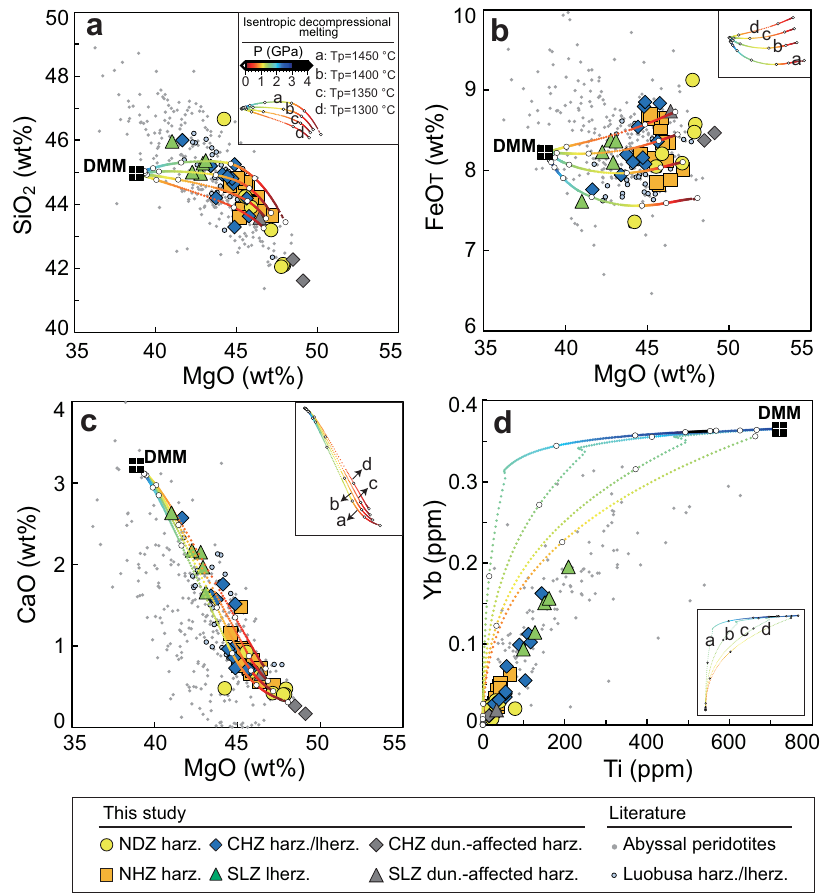
Fig. 3 | Whole-rock compositional variations of the Kangjinla ophiolitic peri- dotites and decompressional melting modeling. Variations of whole-rock MgO (wt%)versusSiO 2 (wt%, a ),FeO T (wt%, b ),andCaO(wt%, c ),aswellaswhole-rockTi (ppm) versus Yb (ppm, d ) for the Kangjinla ophiolitic peridotites. Isentropic decompressional fractional melting trends (color-coded) for residual peridotites from a depleted-MORB-mantle (DMM) source 49 were modeled using the pMELTS version 51 of alphaMELTS 1.9 program 52 , with mantle potential temperatures of